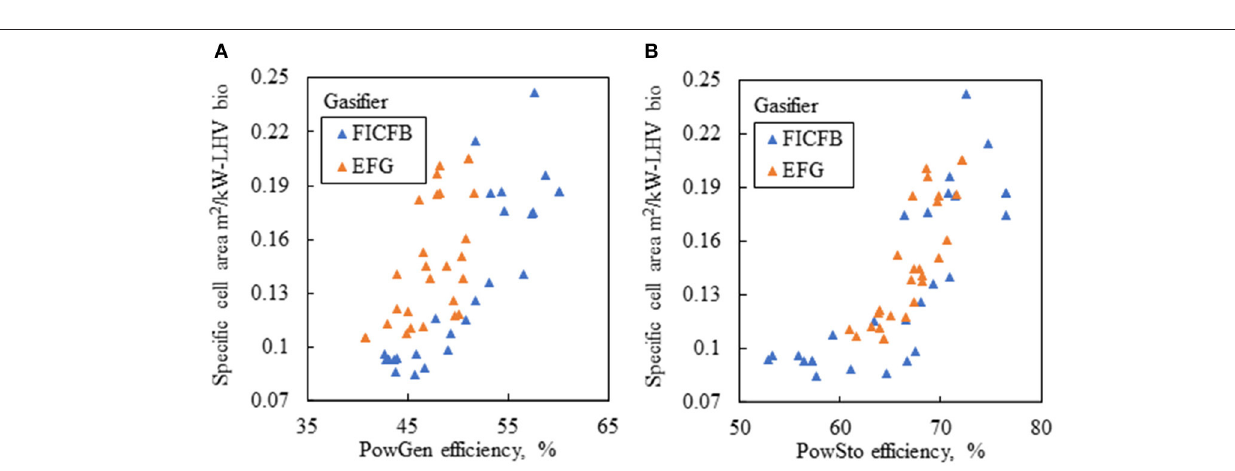
FIGURE 5 | The pool of plant design with FICFB and EFG option: (A) PowGen efficiency vs. specific cell area (B) PowSto efficiency vs. specific cell